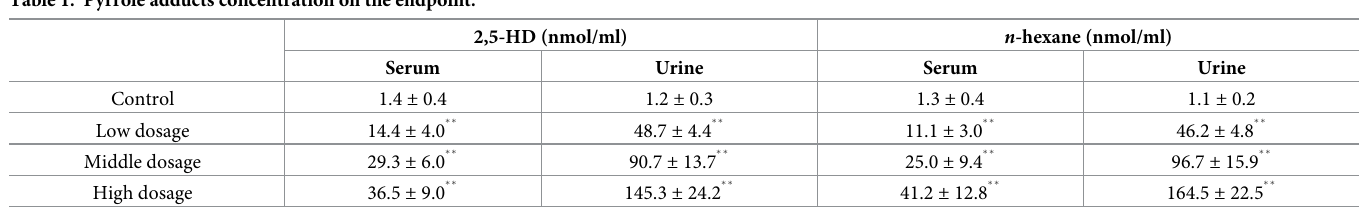
Table 1. Pyrrole adducts concentration on the endpoint.